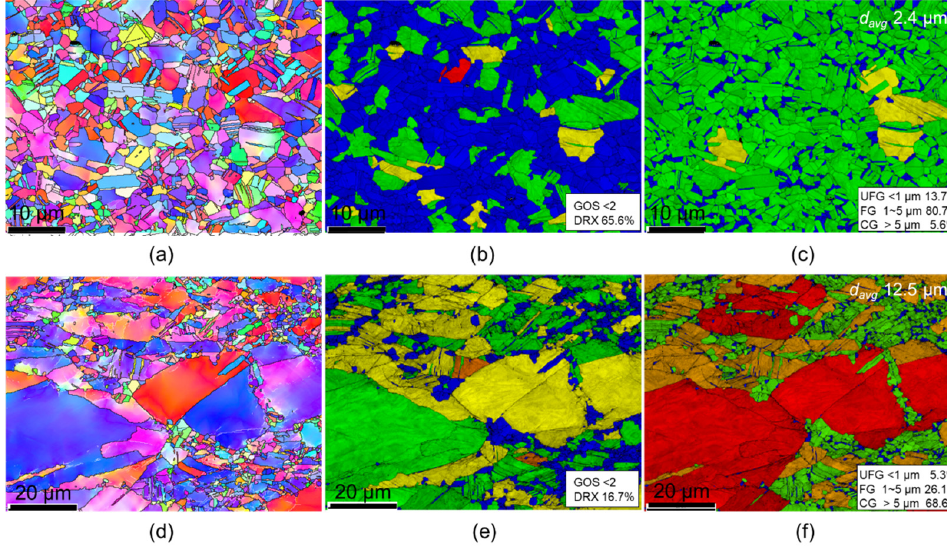
Figure 3. EBSD-IPF ( a , d ), grain orientation spread (GOS) ( b , e ), and grain size ( d , f ) maps of the FG ( a – c ) and CG ( d – f ) samples deformed at a strain of 20%.